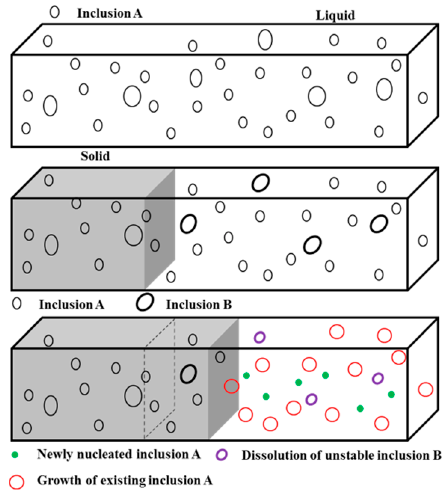
Figure 1. Schematic of the evolution of multi-type inclusions during the cooling and solidification process: Inclusion A nucleation and growth in liquid steel before solidification; some Inclusion A was trapped by the solid steel (gray volume); the Inclusion A in the residual liquid steel grew further and Inclusion B was able to start to nucleate; with the solidification of the steel, Inclusion B started to dissolve (in purple) and Inclusion A continued to grow (in red) and nucleate (in green).